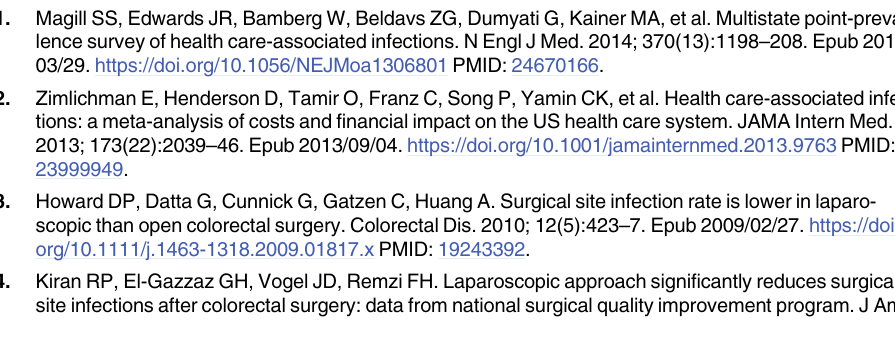
S1 Table. The surgical site infection rates for each year for each surgery. S2 Table. The difference between emergency and scheduled